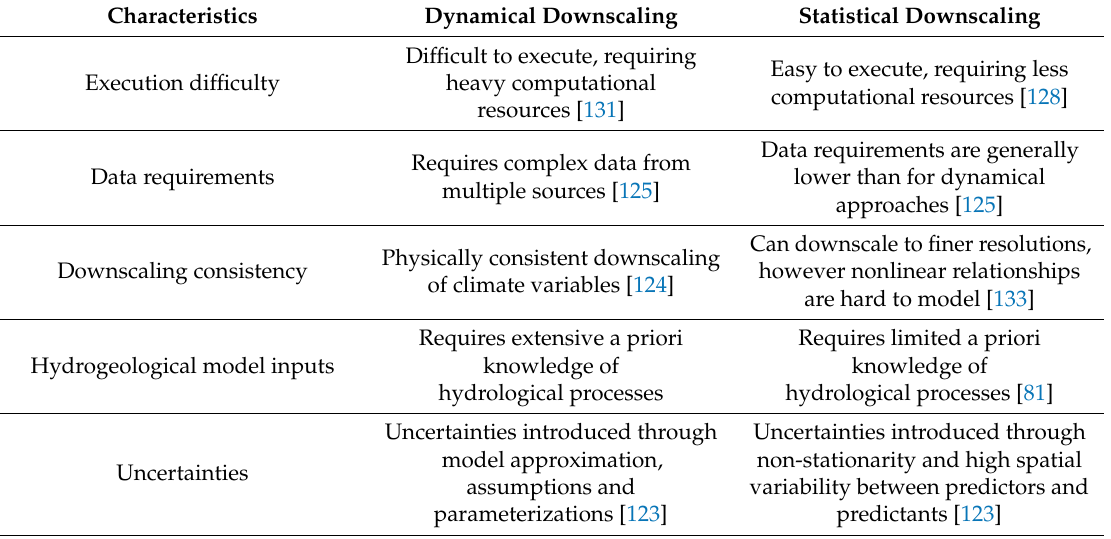
Table 6. Merits and constraints of downscaling